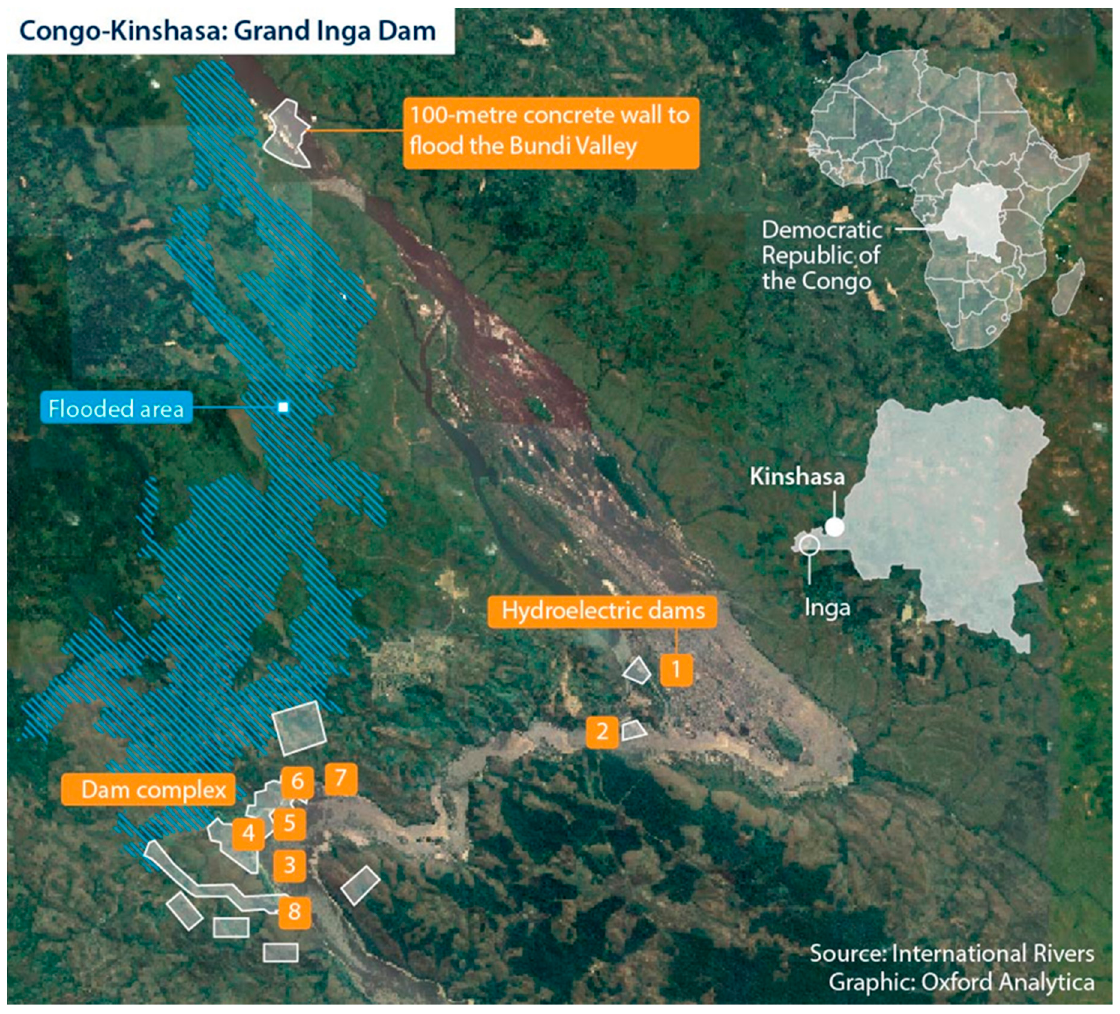
Figure 1. The Inga Valley, the two existing and the six planned dams forming part of the Grand Inga Complex (https://dailybrief.oxan.com/Analysis/GI239798/Congo-Kinshasa-Grand-Inga-dam).